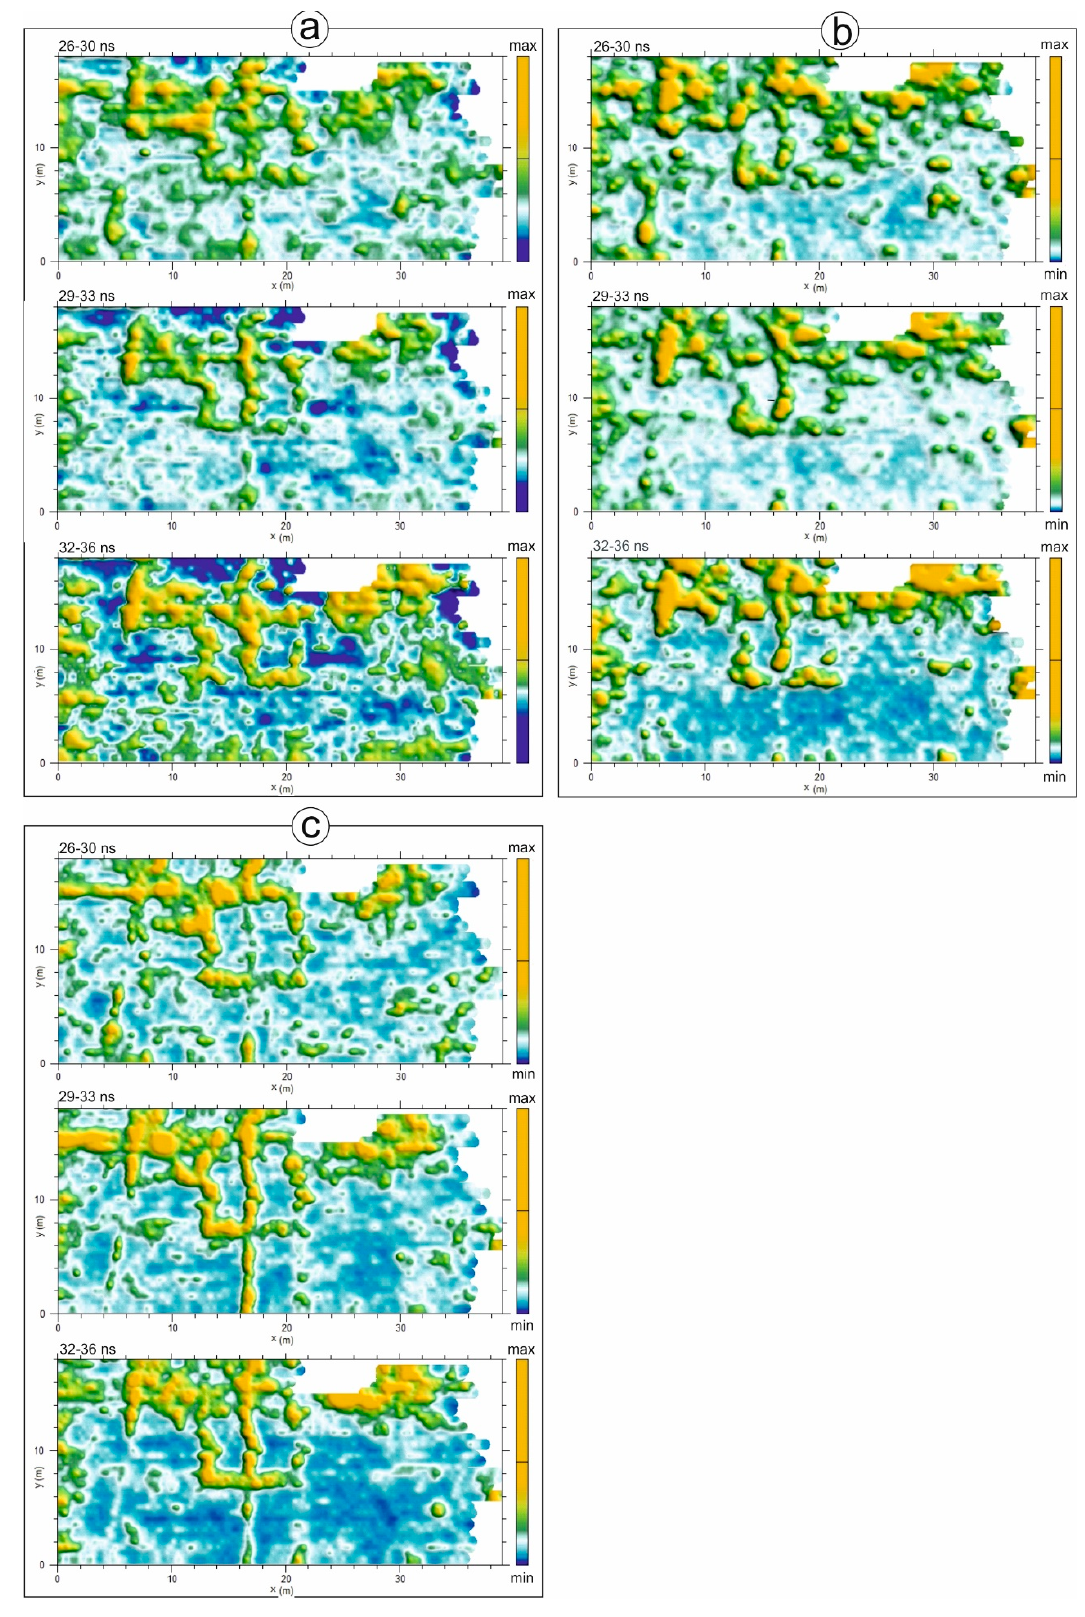
Figure 10. Time-slices generated from ( a ) unmigrated data, ( b ) data migrated with a constant velocity field (10 cm/ns), and ( c ) data migrated according to the varying velocity field.